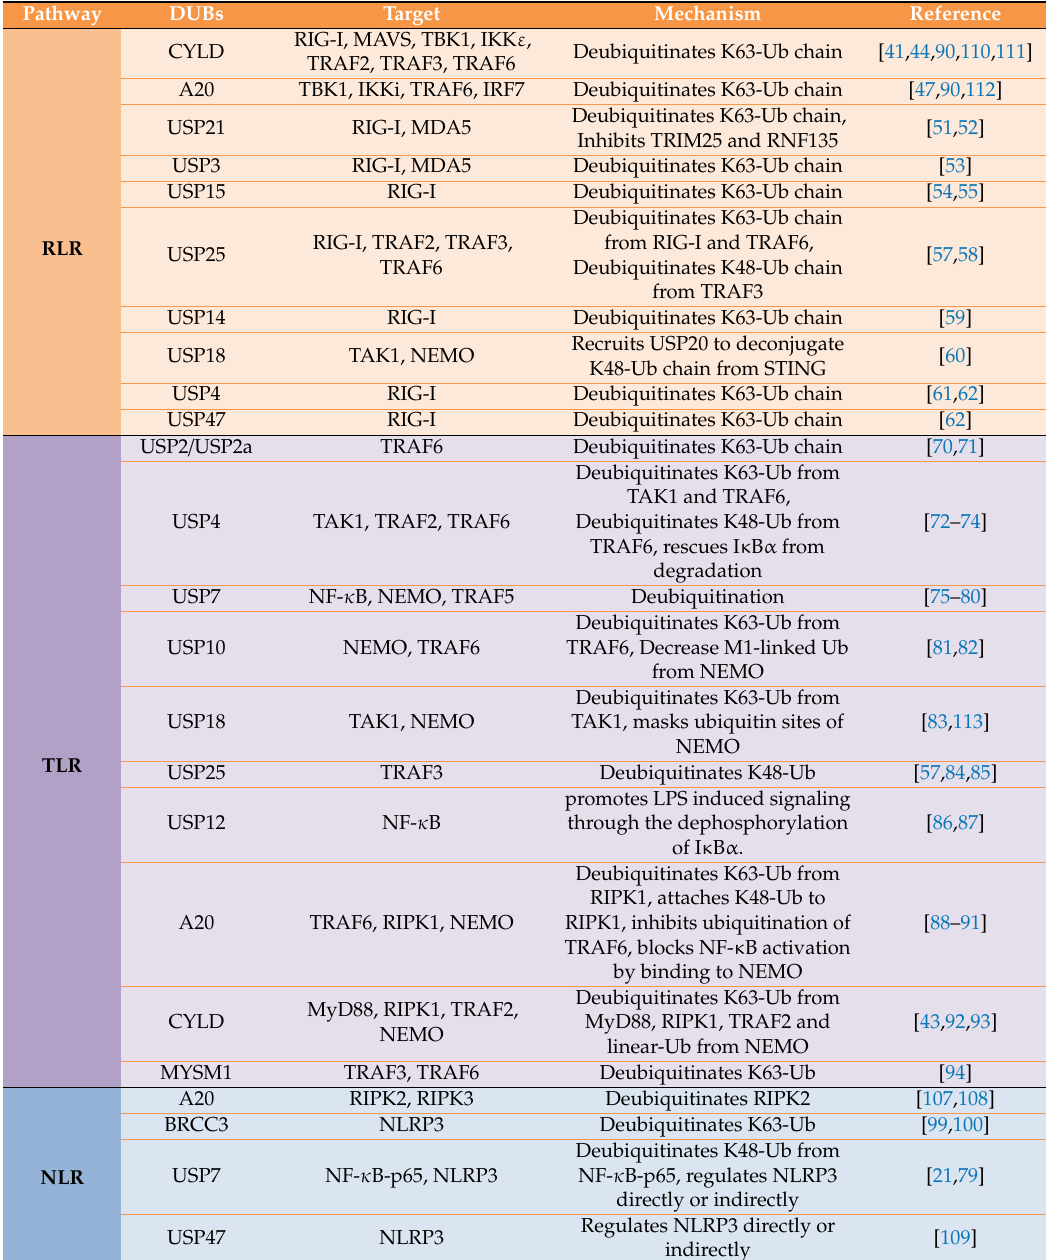
Table 1. DUBs regulating RLR, TLR, and NLR signaling and their